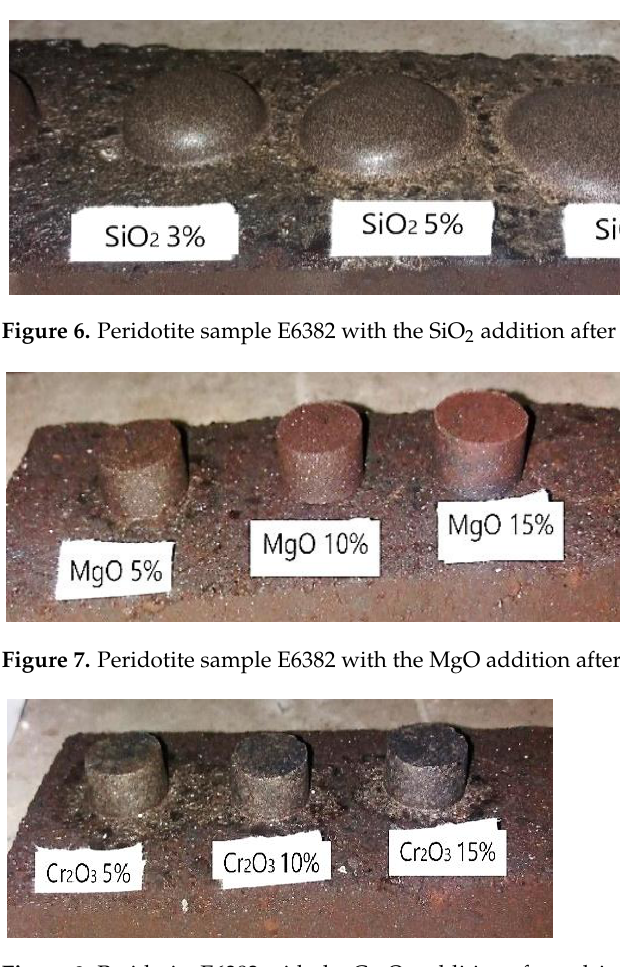
Figure 8. Peridotite E6382 with the Cr 2 O 3 addition after calcination.